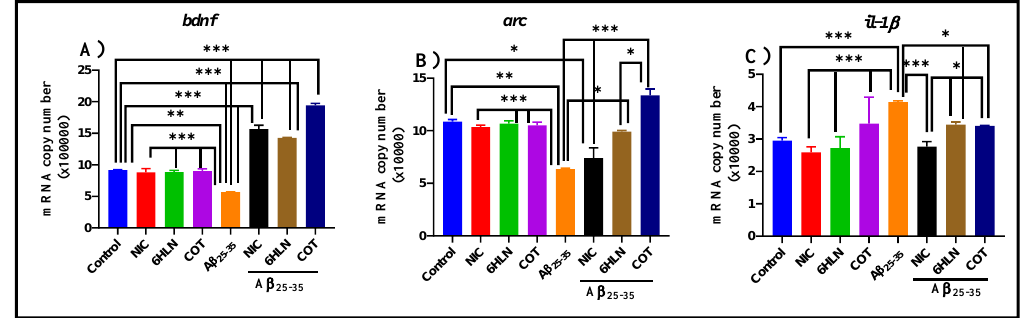
Figure 9. E ff ects of NIC, 6HLN and COT (0.3 mg / kg, b.w., i.p.) administration in A β 25-35 -treated rats on the mRNA copy number of ( A ) bdnf , ( B ) arc and ( C ) il-1 β from the hippocampus. The values are expressed as means ± S.E.M. ( n = 6 animals per group). ANOVA analysis identified general significant di ff erences between groups in ( A ) F(4.10) = 291.7, p < 0.0001, ( B ) F(4.10) = 28.73, p < 0.0001 and ( C ) F(4,10) = 33.48, p < 0.0001. For Tukey post hoc analyses–( A ) *** Control vs. NIC + A β 25-35 , Control vs. 6HLN + A β 25-35 , Control vs. COT + A β 25-35 , NIC vs. A β 25-35 , 6HLN vs. A β 25-35 , COT vs. A β 25-35, A β 25-35 vs. NIC + A β 25-35 , A β 25-35 vs. 6HLN + A β 25-35 , A β 25-35 vs. COT + A β 25-35 , NIC + A β 25-35 vs. COT + A β 25-35 , 6HLN + A β 25-35 vs. COT + A β 25-35 : p < 0.0001; ( B ) * Control vs. NIC + A β 25-35 , A β 25-35 vs. 6HLN + A β 25-35 , 6HLN + A β 25-35 vs. COT + A β 25-35 : p < 0.01, ** Control vs. A β 25-35 : p < 0.001, *** NIC vs. A β 25-35 , 6HLN vs. A β 25-35 , COT vs. A β 25-35, A β 25-35 vs. NIC + A β 25-35 , A β 25-35 vs. COT + A β 25-35 : p < 0.0001; ( C ) *** Control vs. A β 25-35 , NIC vs. A β 25-35 , 6HLN vs. A β 25-35 , COT vs. A β 25-35, A β 25-35 vs. NIC + A β 25-35 : p < 0.0001, * A β 25-35 vs. 6HLN + A β 25-35 , A β 25-35 vs. COT + A β 25-35 , NIC + A β 25-35 vs. 6HLN + A β 25-35 , NIC + A β 25-35 vs. COT + A β 25-35 : p < 0.01.